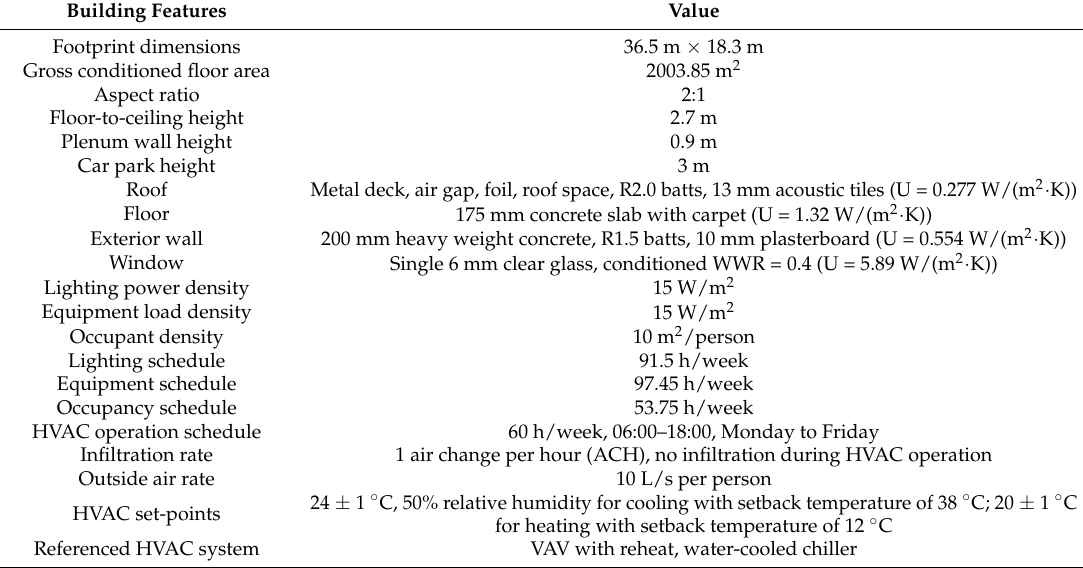
Table 2. Building physical properties and general modelling assumptions [56].